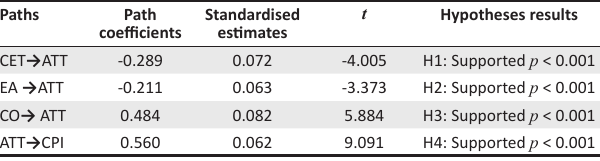
TABLE 4: Structural equation modelling hypotheses testing